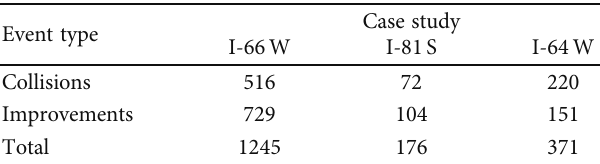
Table 3: Frequency of events by type for April 1 to October 31 in